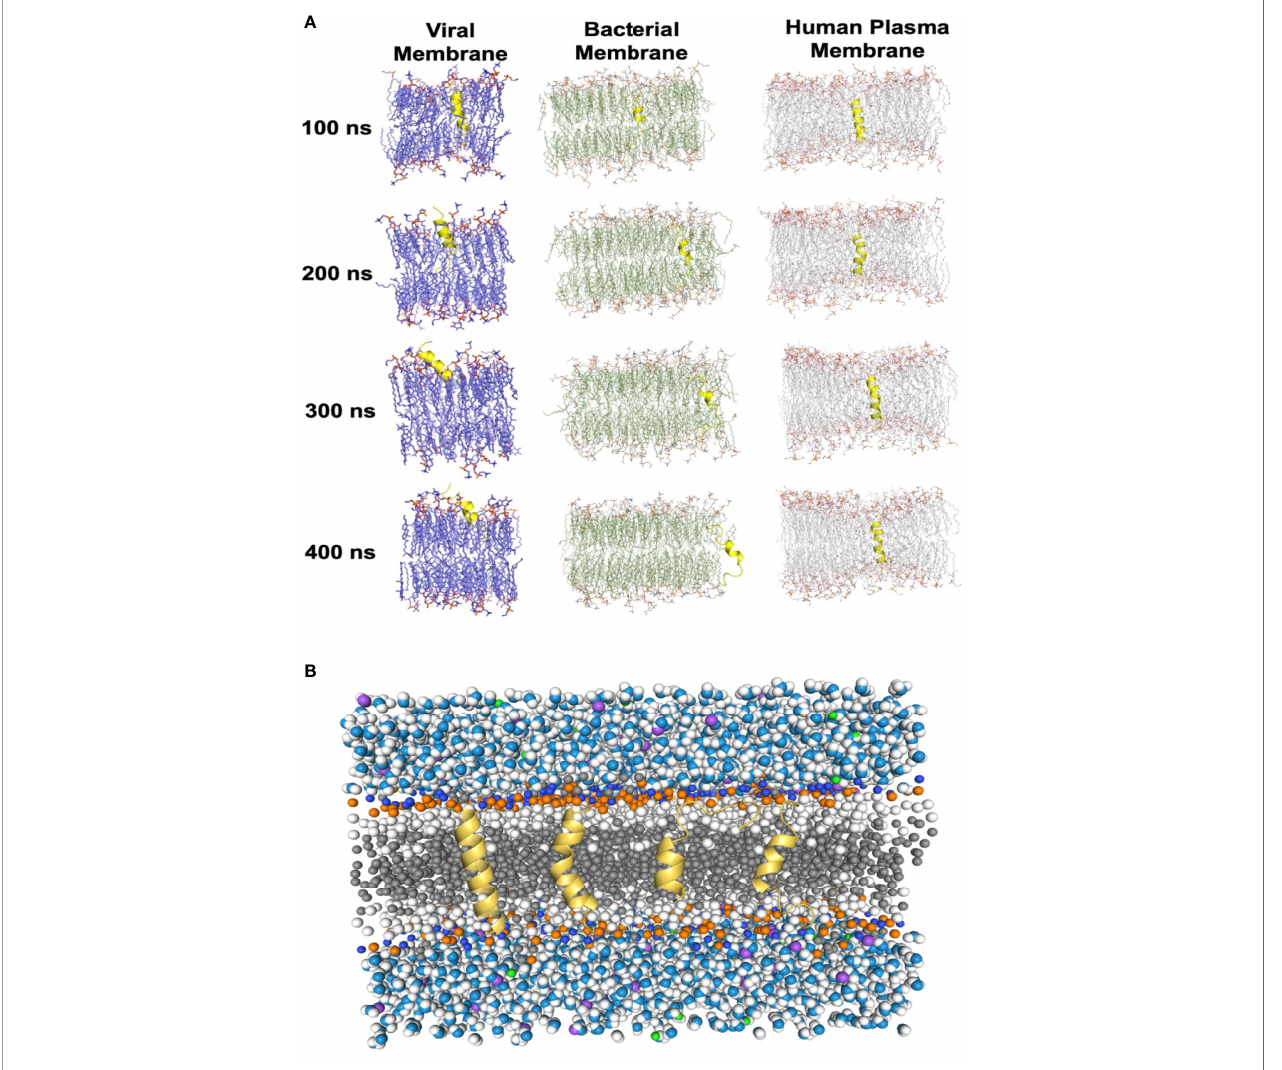
FIGURE 6 | Molecular dynamics simulations of the Bomidin – membrane interactions. (A) Snapshots of the Bomidin and bilayer membrane dynamic systems throughout the 400 ns trajectories. Bomidin interacted strongly with anionic phospholipid bilayers with a preference for fl uid layers. Membrane penetrations or disruptions were observed for viral/bacterial membrane models (left/middle panel). The elevated cholesterol-to-phospholipid molar ratio (commonly seen in mammalian plasma membranes) and decrease in membrane fl uidity can shield the membrane from the action of the peptide (right panel). (B) Lateral view of the overall simulated system with a bilayer of lipids (dark gray) immersed in water (blue/white spheres) and ions (purple/green spheres). Conformations sampled by Bomidin (yellow) are